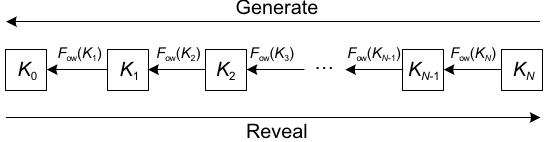
Fig. 1 Generating and revealing order of a typical one-way chain in TESLA